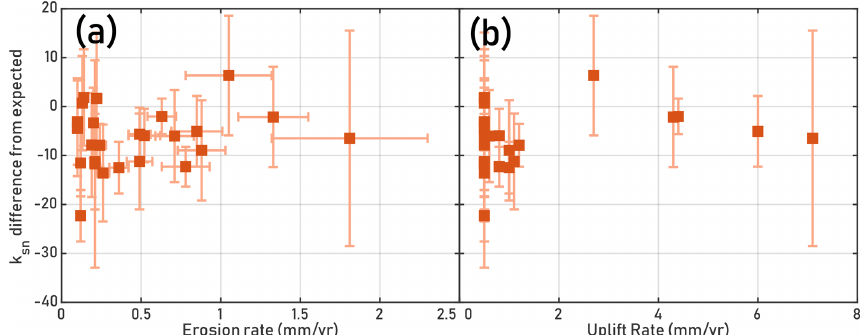
Figure 7. Difference from expected normalized steepness index in tributaries within basins shown in Fig. 6 vs. erosion and uplift rates. Expected k sn at tributary elevation was calculated based on same spline fit shown in Fig. 3. (a) k sn difference from expected in tributaries versus Beryllium-10-derived denudation rates (Godard et al., 2014). Spearman’s ρ = − 0 . 0306 with P = 0 . 5167. Vertical error bars represent 1 standard deviation among tributary k sn values for each basin analyzed. Horizontal bars are errors reported from Godard et al. (2014). (b) Same k sn difference from expected in tributaries versus uplift rates (Lavé and Avouac, 2001). Spearman’s ρ = − 0 . 0088 with P = 0 .